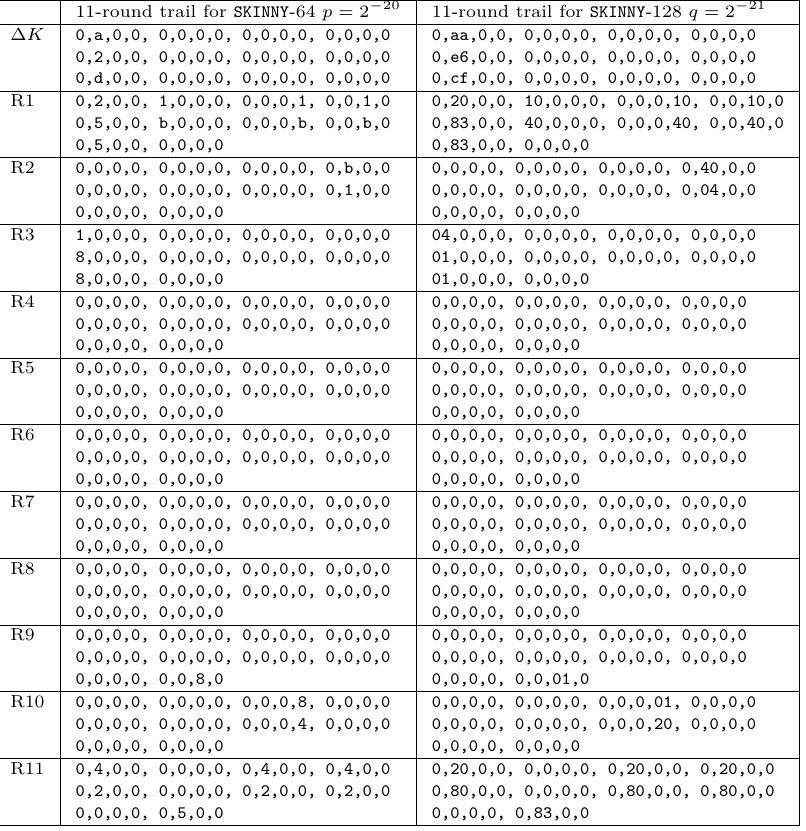
Table 8: Differential trails of SKINNY - n -3 n [LGS17] 11-round trail for SKINNY -64 p = 2 − 20 11-round trail for SKINNY -128 q = 2 − 21 ∆